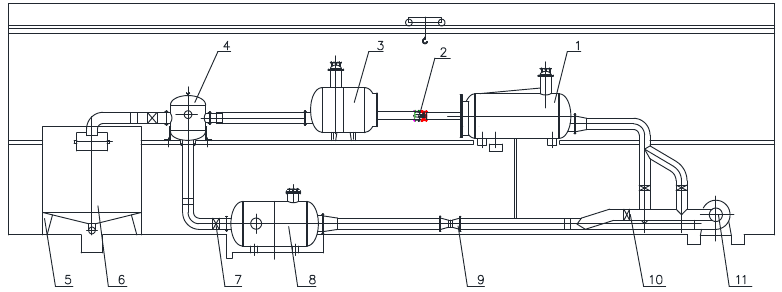
Figure 5. Plan of high precision hydraulic machinery test bench. 1. Water inlet tank; 2. Tested pump;